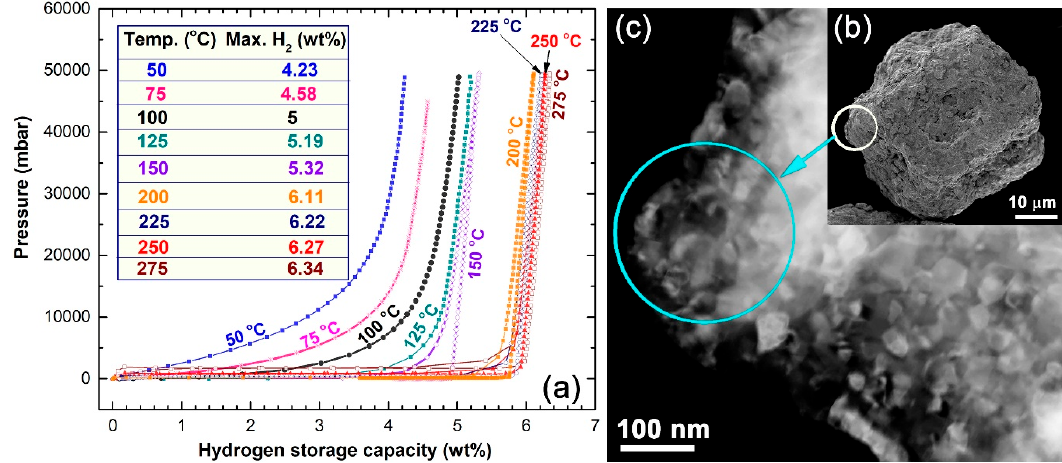
Figure 9. ( a ) Pressure ‐ Composition ‐ Temperature (PCT) curves measured at different temperatures (50 °C–275 °C) for MgH 2 powders milled with Zr 2 Ni balls for 50 h, ( b ) SEM micrograph of the powders obeyed to PCT cycles at different temperature. The STEM/BF image of the indexed zone shown in ( b ) is presented in ( c ).